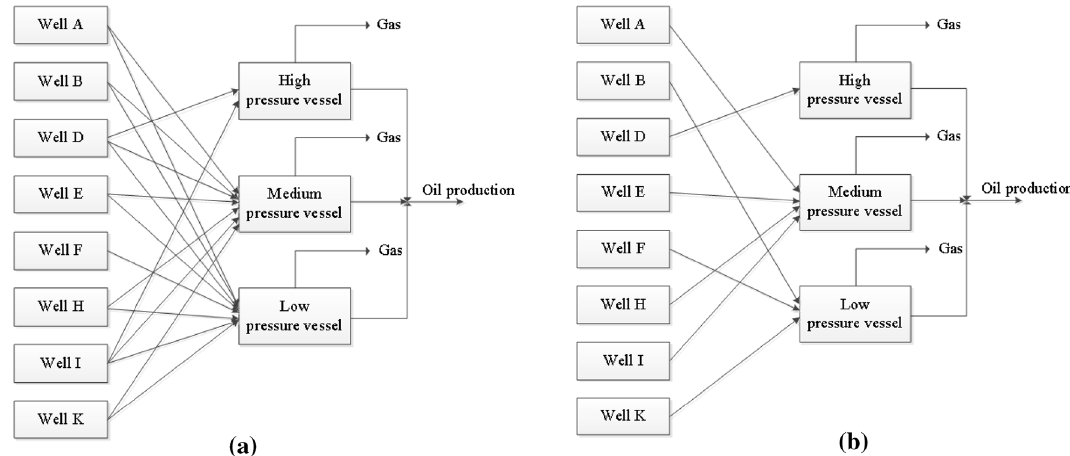
Fig. 5 Connections from wells to the pressure vessels, a the developed superstructure of the wells and pressure vessels, and b the optimum con- nection